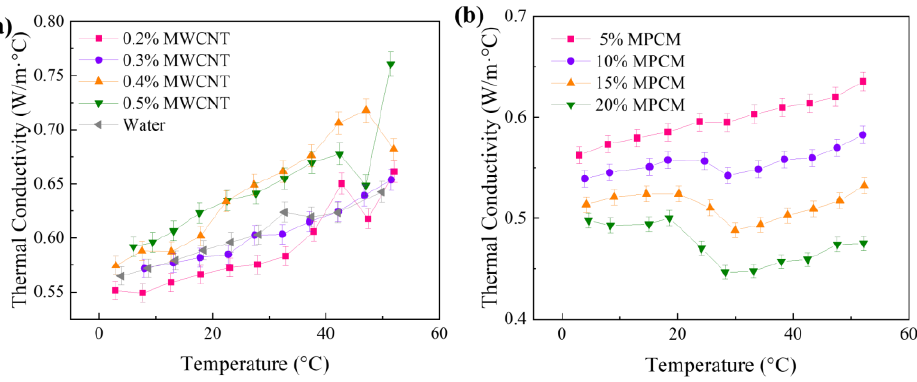
Figure 5. Thermal conductivity in various temperatures: ( a ) MWCNT water dispersion and ( b ) MPCM slurry. ( b ) MPCM